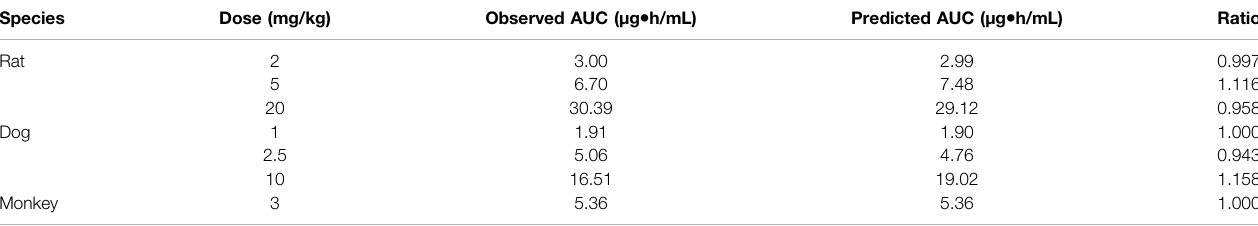
TABLE 4 | Predicted and observed pharmacokinetic AUC in rats, dogs, and monkeys receiving a single dose of ST-246. Species